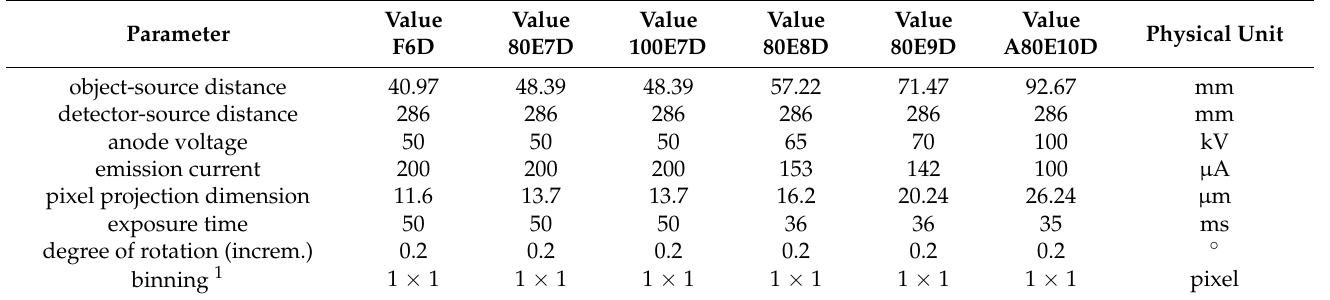
Table A3. Values of set parameters on SkyScan